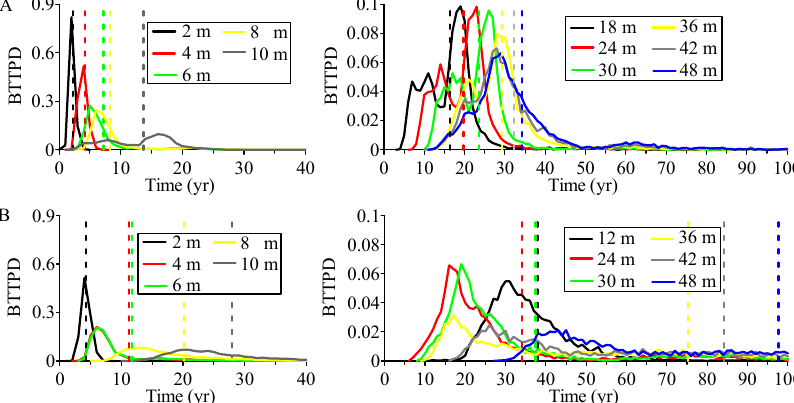
Figure 6. Simulated BTTPD represented by a point at different depths along a column inside of the IVF ( A ) and outside of the IVF ( B ). The column coordinate is X = 7100 m, Y = 6900 m for ( A ), and X = 3600 m, Y = 3300 m for ( B ). In the legend, the number represents location (depth below the water table). The dashed line represents the mean age for each BTTPD (same color).